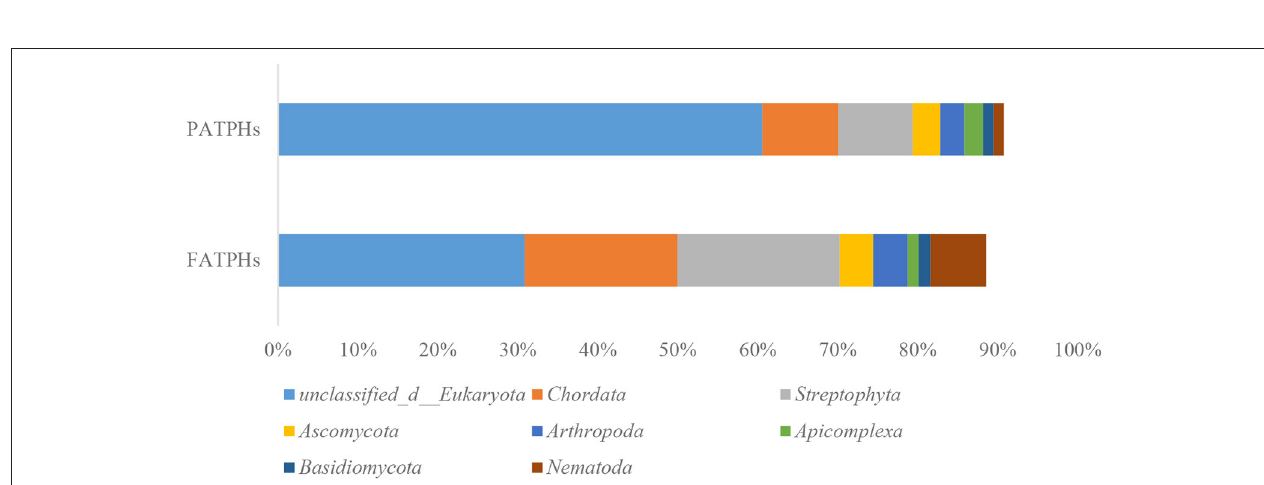
FIGURE 6 | Relative abundances of eukaryota phyla ranked by one and zero orders of magnitude in PATPHs shown together with relative abundances of the corresponding phyla in FATPHs.